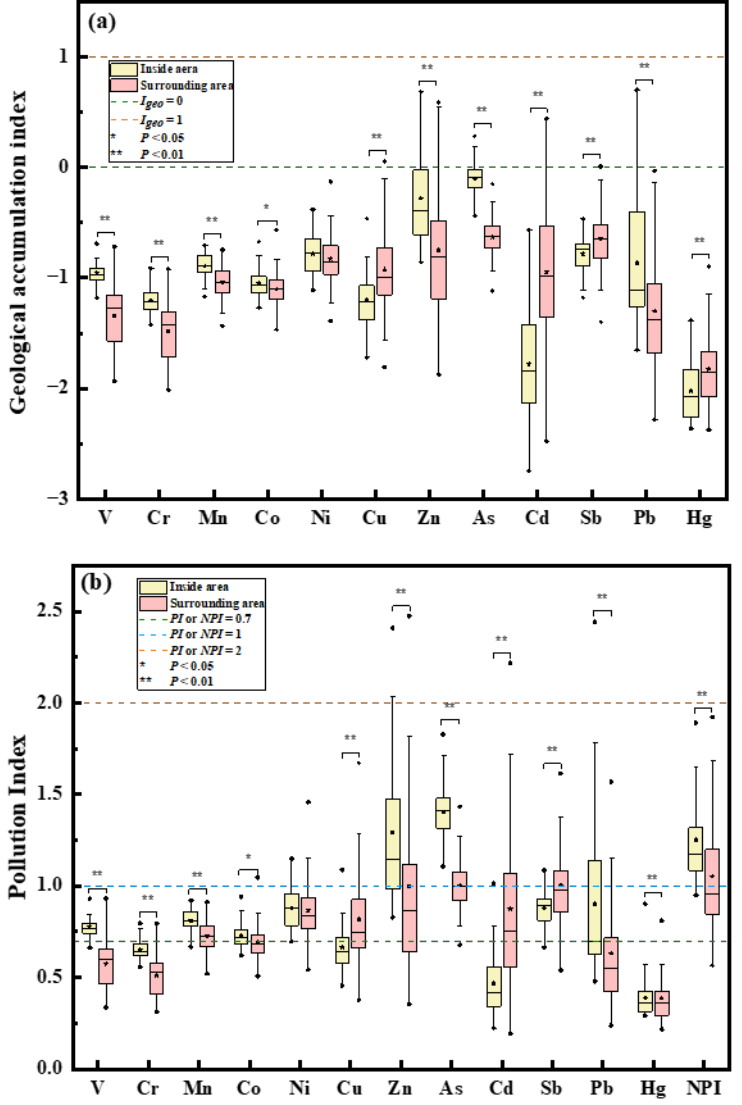
Figure 2. The Geological accumulation indices ( a ) and the Pollution indices ( b ) of HMs inside and around the petrochemical complex.